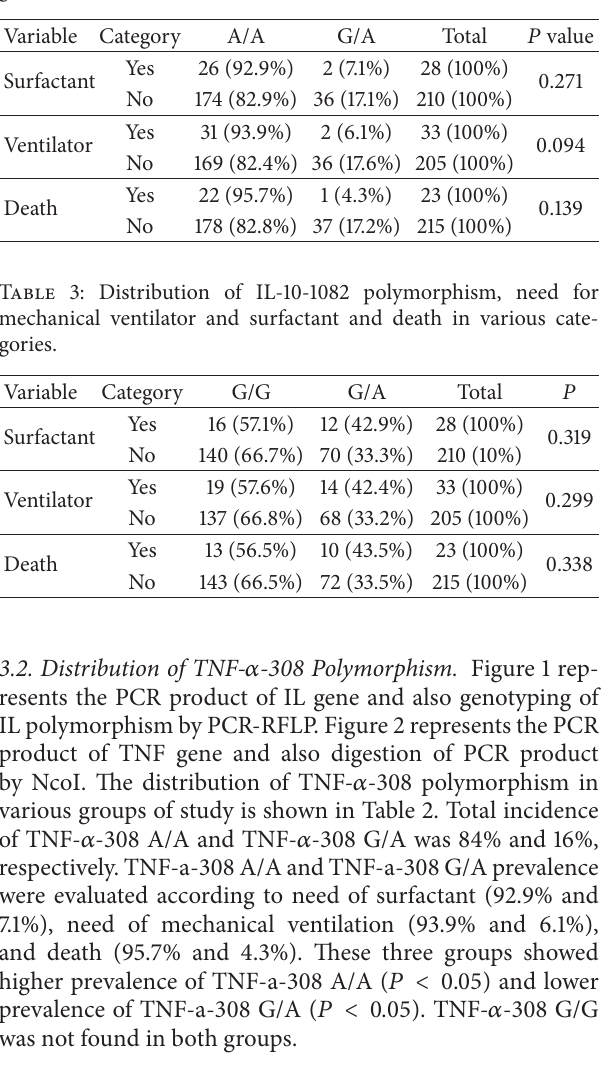
Table 1: Some characters of infants in the study groups. Table 2: Distribution of TNF- 𝛼 -308 polymorphism, need for mechanical ventilator and surfactant and death in various cate- gories.